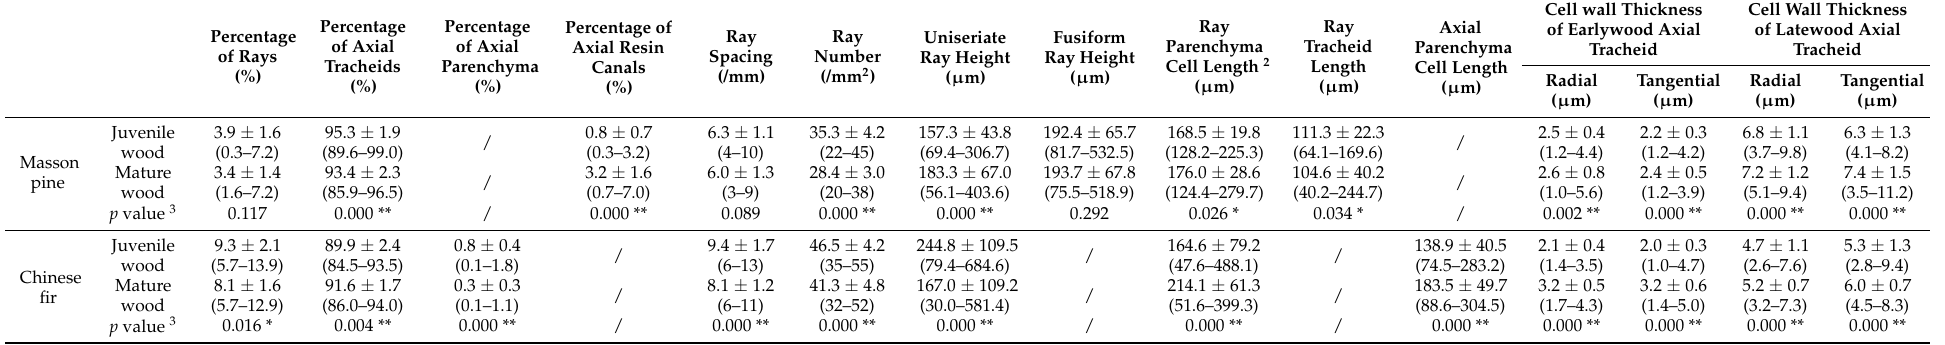
Table 2. Wood anatomical features measured in Masson pine and Chinese fir as well as ANOVA results of juvenile wood and mature wood, respectively 1 . Percentage of